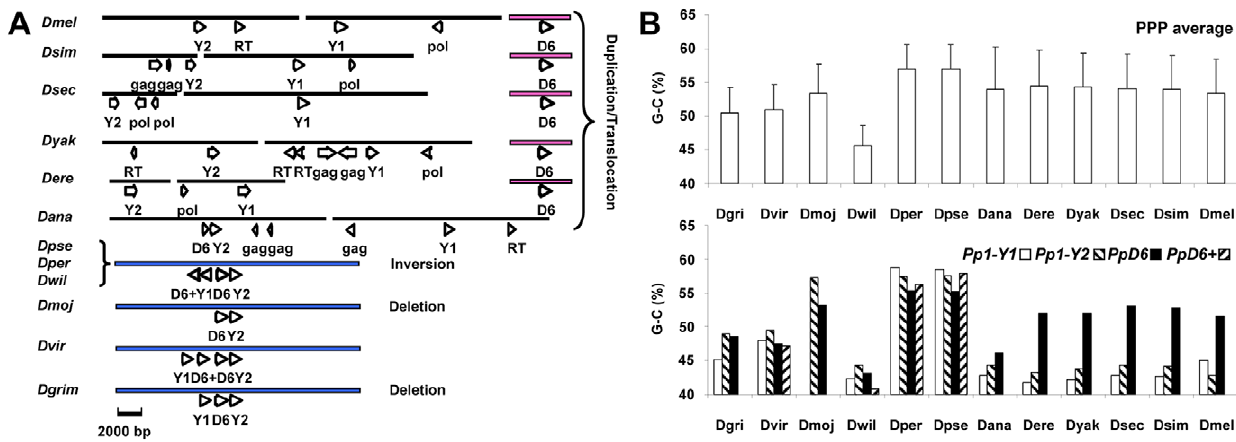
Figure 5. Rearrangements of the PpD6 , PpD6 + , Pp1-Y1 , Pp1-Y2 gene cluster. ( A ) Chromosomal localizations of PpD6 (D6), PpD6 + (D6 + ), Pp1- Y1 (Y1), and Pp1-Y2 (Y2) genes. Chromosome segments are symbolized by horizontal bars, the coloring identifies Muller elements C, B and chromosome Y in blue, pink, and black, respectively. The directions of the coding regions are indicated by arrows, pointing from 5 9 to 3 9 in the sense strand. In chromosome Y the positions and orientations of inactive viral reverse transcriptase ( RT ), pol and gag genes are also shown for orientation; here the arrows represent only the relative directions within a short DNA segment. ( B ) The G 2 C content in the coding regions of the PpD6 , PpD6 + , Pp1- Y , and Pp1-Y2 genes. The upper part of the panel shows the average G 2 C content + SD for all PPP genes of a given species, while the lower part depicts the G 2 C content of the four selected phosphatases.